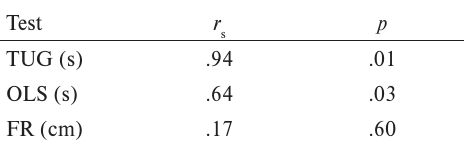
The correlations between pre and post-intervention of Timed Up-and-Go (TUG), One-Leg Stance (OLS) and Functional Reach (FR) test Test r s